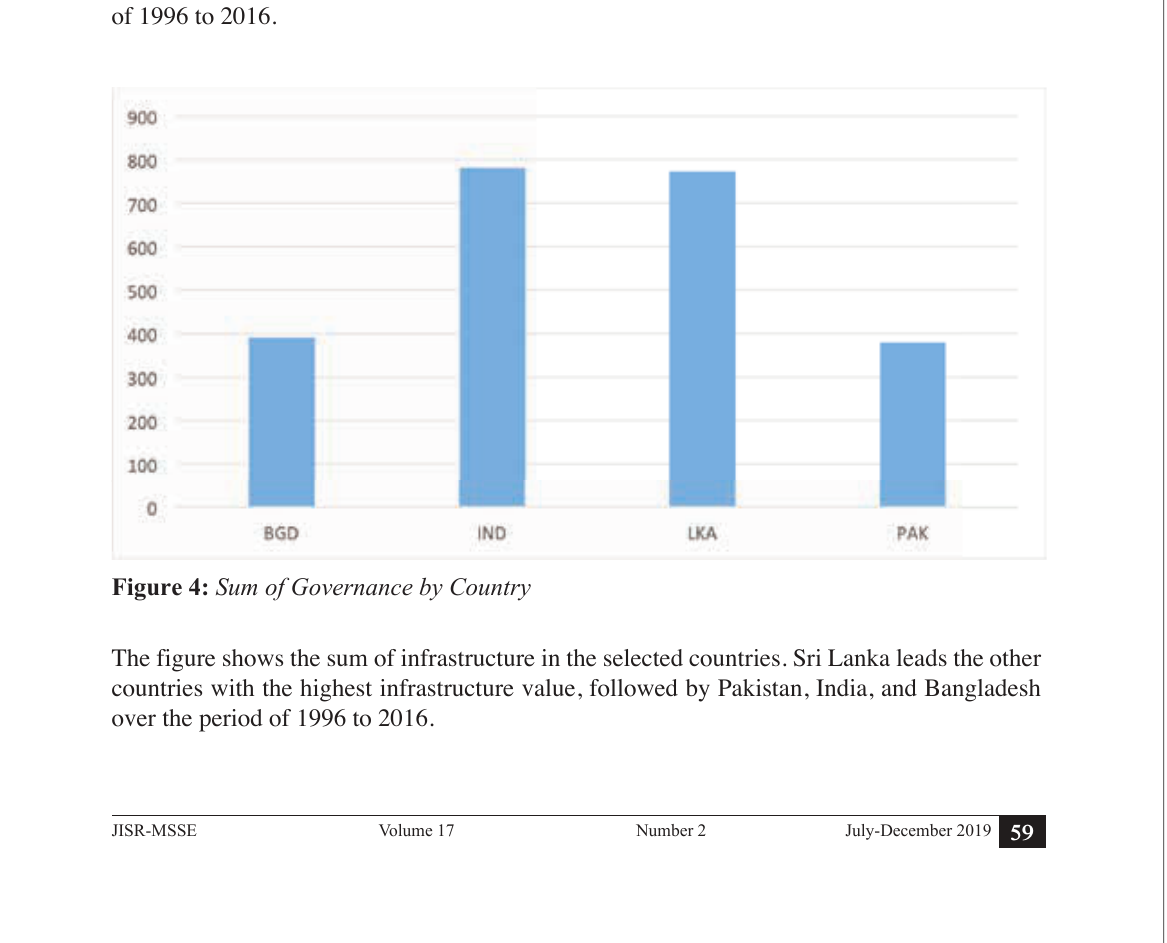
Figure 3: Sum of Openness by Country